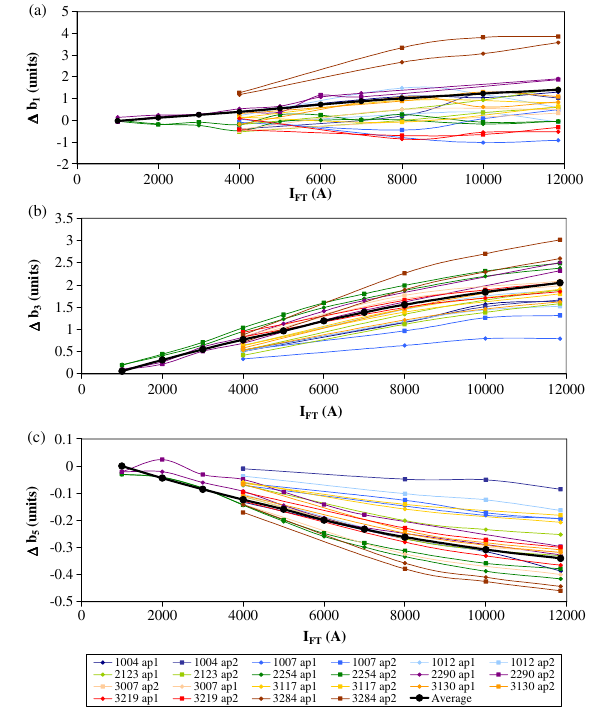
FIG. 13. (Color) The variation of the decay amplitude with flattop current for (a) b